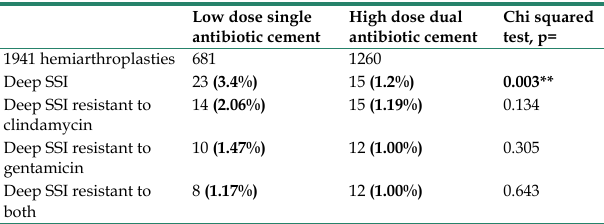
Table 4. Number of resistant infections